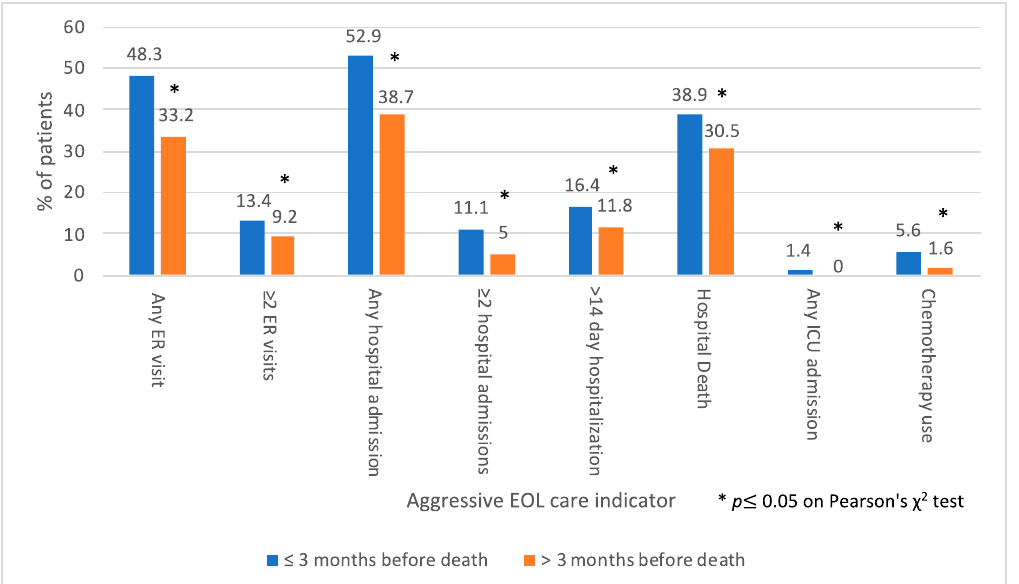
patient group receiving early (>3 months before death) palliative care consultation was receiving early (>3 months before death) palliative care consultation was lower than in lower than in that receiving later palliative care consultation ( ≤ 3 months before death) that receiving later palliative care consultation ( ≤ 3 months before death) (0.15 versus 0.31, (0.15 versus 0.31, p < 0.001). p < 0.001).